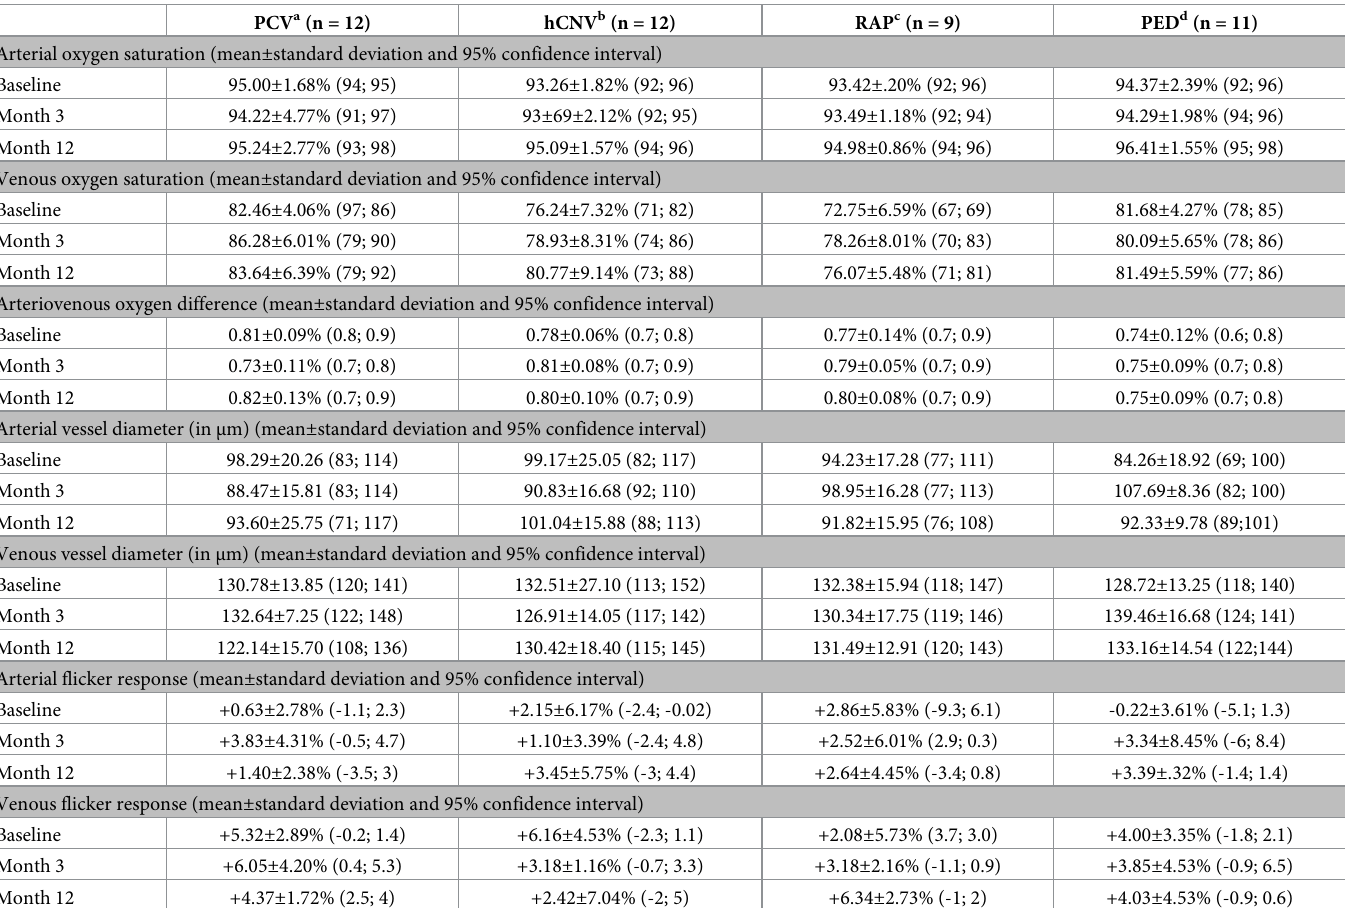
Mean ± standard deviation and 95% confidence interval of all values is provided.